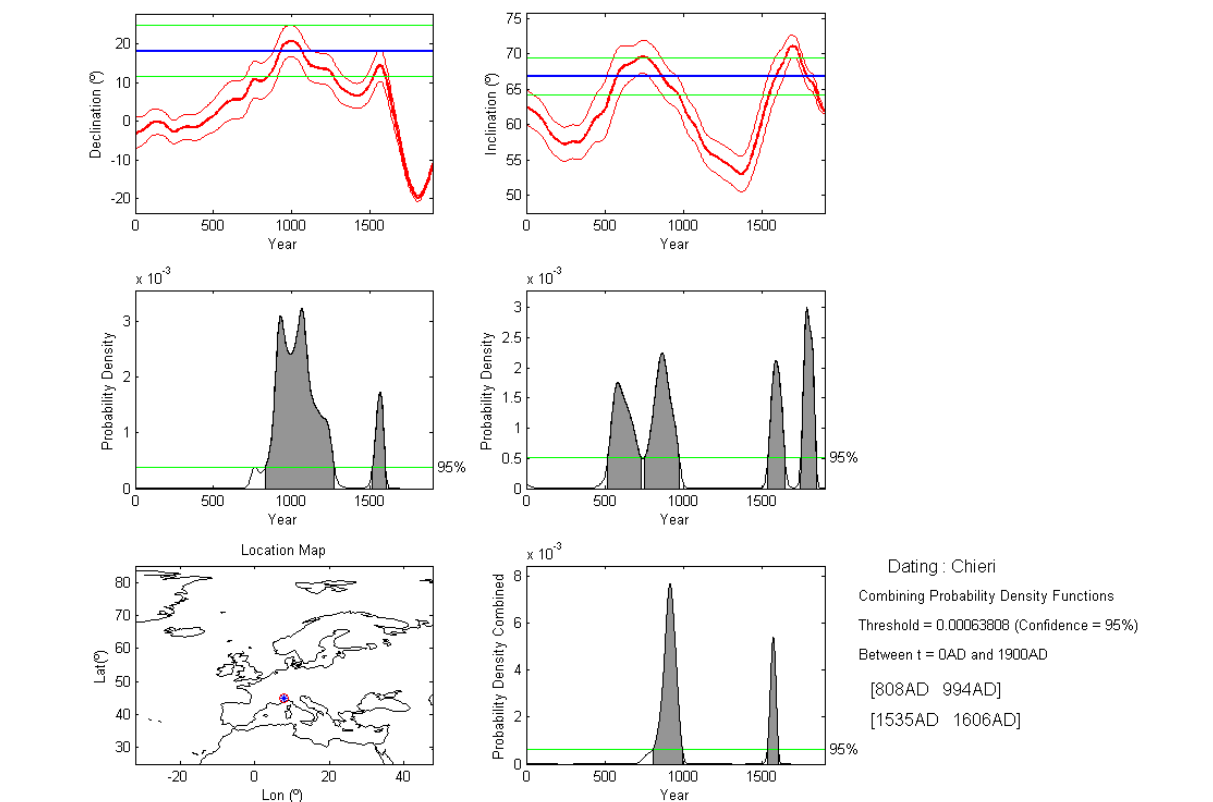
Figure 6. Archaeomagnetic dating results. Up: declination (left) and inclination (right) reference secular variation curves calculated from the SCHA.DIF.3K model (red curve with error band) and the kiln’s measured direction (blue line with green error band); middle: calculated prob- ability density functions for declination (left) and inclination (right); down: combined probability density function for declination and